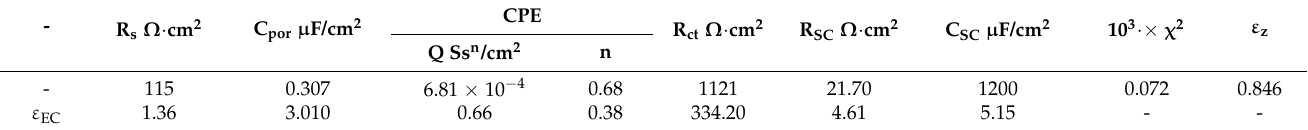
Table 6. Equivalent circuit parameters R (C (R (QR))) (CR) for PPS in seawater in the initial moments.